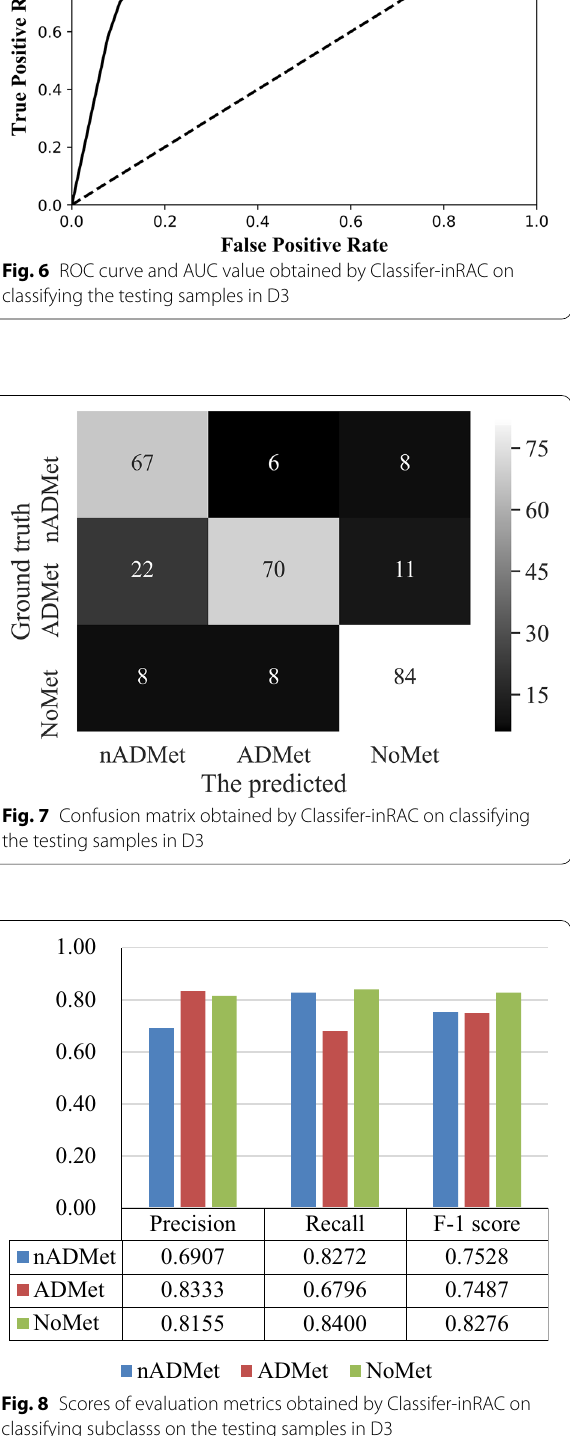
Fig. 8 Scores of evaluation metrics obtained by Classifer-inRAC on classifying subclasss on the testing samples in